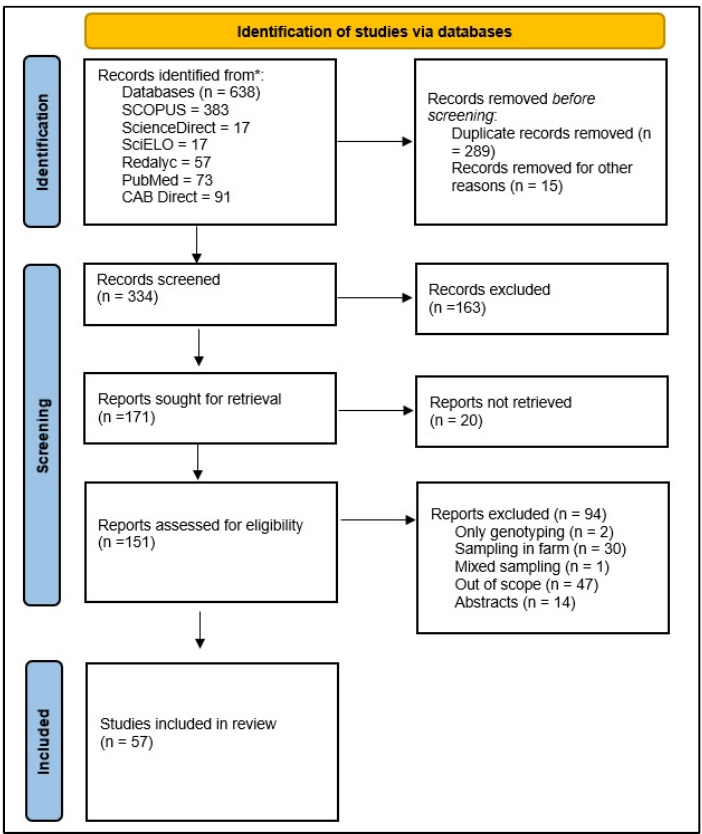
Figure 2. PRISMA flowchart diagram of the record selection Figure 2. Prisma flowchart diagram of the record selection process.